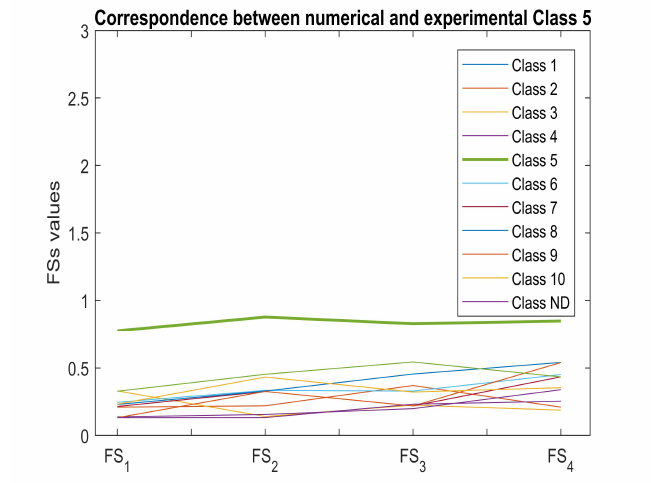
Figure 8. Example of correspondence between the numerical EC map representative of a class of defects with the EC experimental map of the same class.